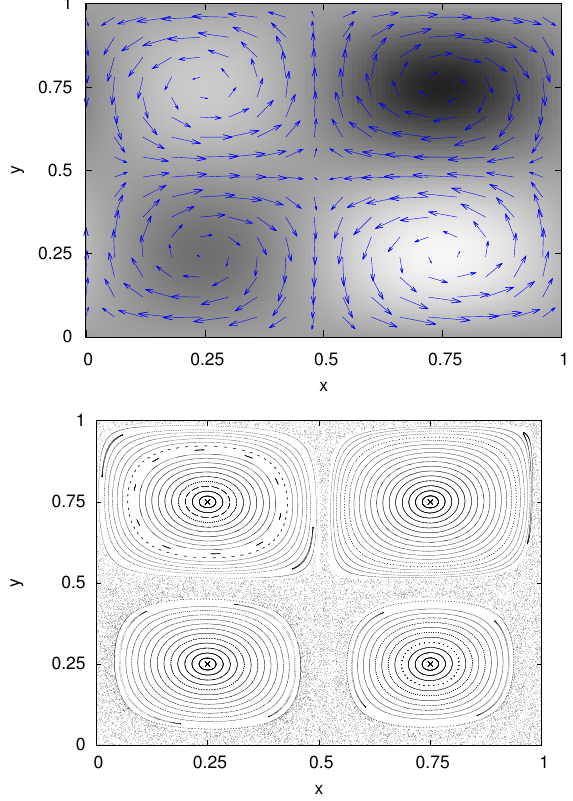
Fig. 1. Top panel shows the velocity field (arrows) and the height field (shaded) of the linear shallow water equations for typical initial conditions used in this paper. We will focus on Lagrangian dynamics near the saddle at ( x,y ) = (0 . 5 , 0) and the center at (x,y) = (0 . 25 , 0 . 25) . The Poincar´e plot at the bottom shows a number of different orbits - some quasiperiodic orbits on invariant circles, some periodic orbits, and some chaotic orbits near the two separatrices at x = 0 . 5 and y = 0 . 5 . This plot shows that some part of the phase space for the Lagrangian trajectories is chaotic while some is regular. leads to initial Gaussian distributions being distorted into “annulus” shaped non-Gaussian distributions (see, e.g., Fig. 4). 2. The shear effect is the basic feature of the time-independent flow and the time-dependent flow modifies it 110 only slightly. Thus trajectories near the centre contain information mostly about the first Fourier mode u 0 and much less about the other modes u 1 ,v 1 ,h 1 . This will again be revealed by the posterior distributions of these variables. 3. The middle panel shows dynamics near the separatrix at x = 0 . 5 . We note that the origin of the saddle effect in data assimilation is not just the divergence near the saddle which is a purely linear effect, but the 115 “differential divergence” (as shown by the distortion of the line of initial conditions in the small inset on top right). It is the latter of the two that leads to non-Gaussian distributions.